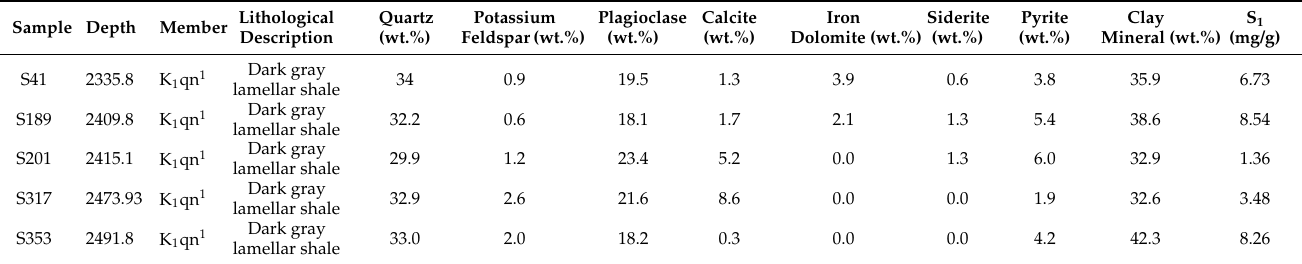
Table 1. Mineralogy and oil-bearing characteristics of the studied samples.